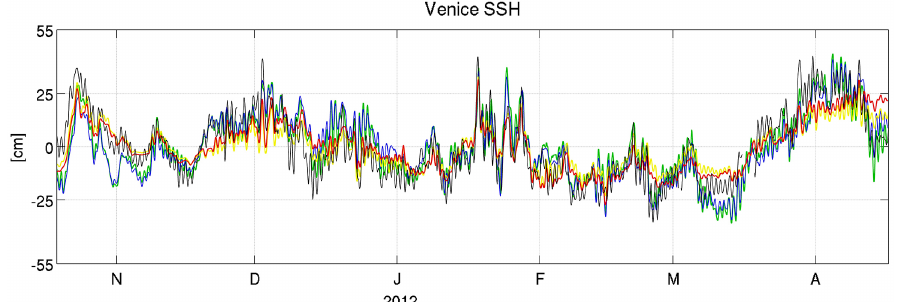
Figure 10. Venice η time-series from observations and model results. Data and model results have been filtered with 5h running mean. Observations, black; NEMO-MFS1, red; NEMO-MFS2, blue; NEMO-MFS3, yellow; NEMO-MFS4, green.